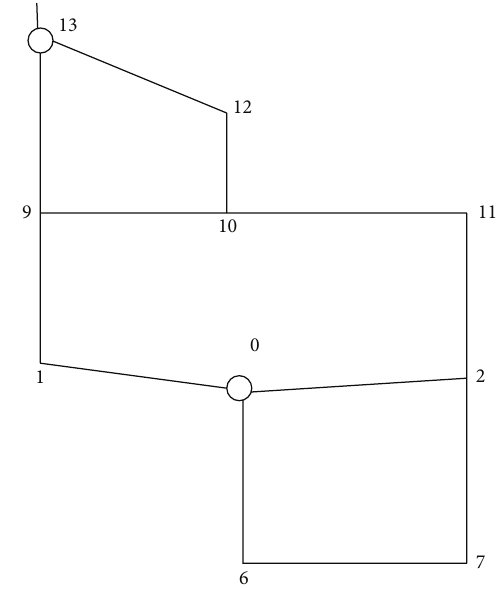
Figure 4: Simplified road sections in one-to-one